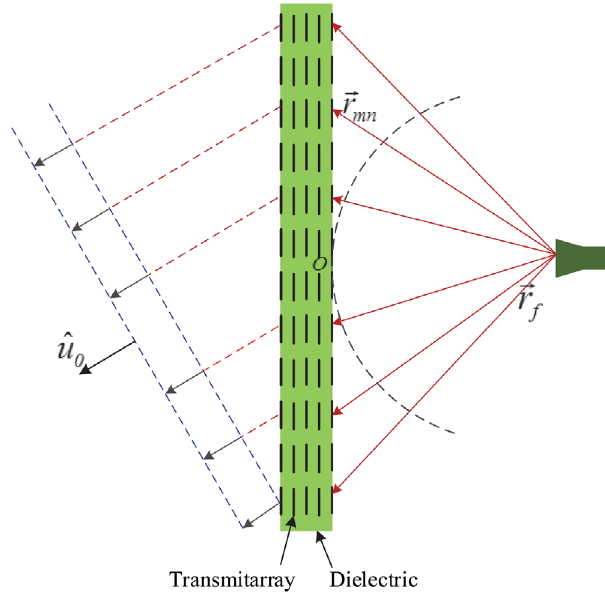
Fig. 1. The con fi guration of proposed high-gain antenna with MNMS.